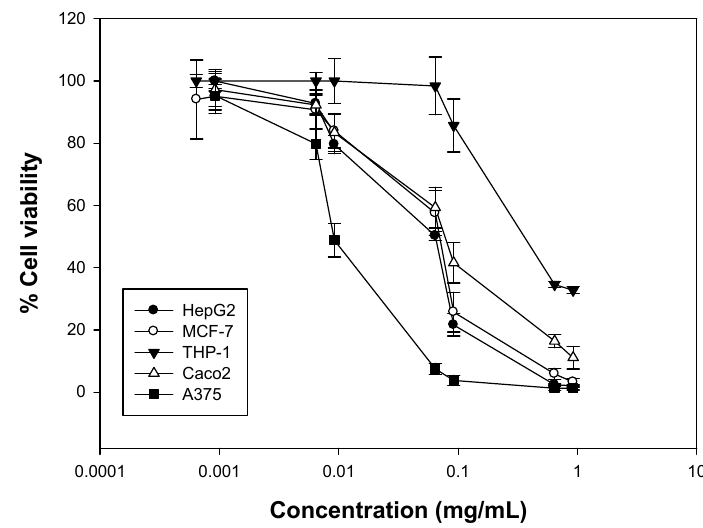
Figure 3. Antiproliferative activity of Lippia citriodora oil against a panel of five human cancer cell lines. Cancer cells were incubated with increasing concentrations of citral for 72 h. Estimation of cell viability was determined by the SRB assay. Representative figures of at least three experiments.